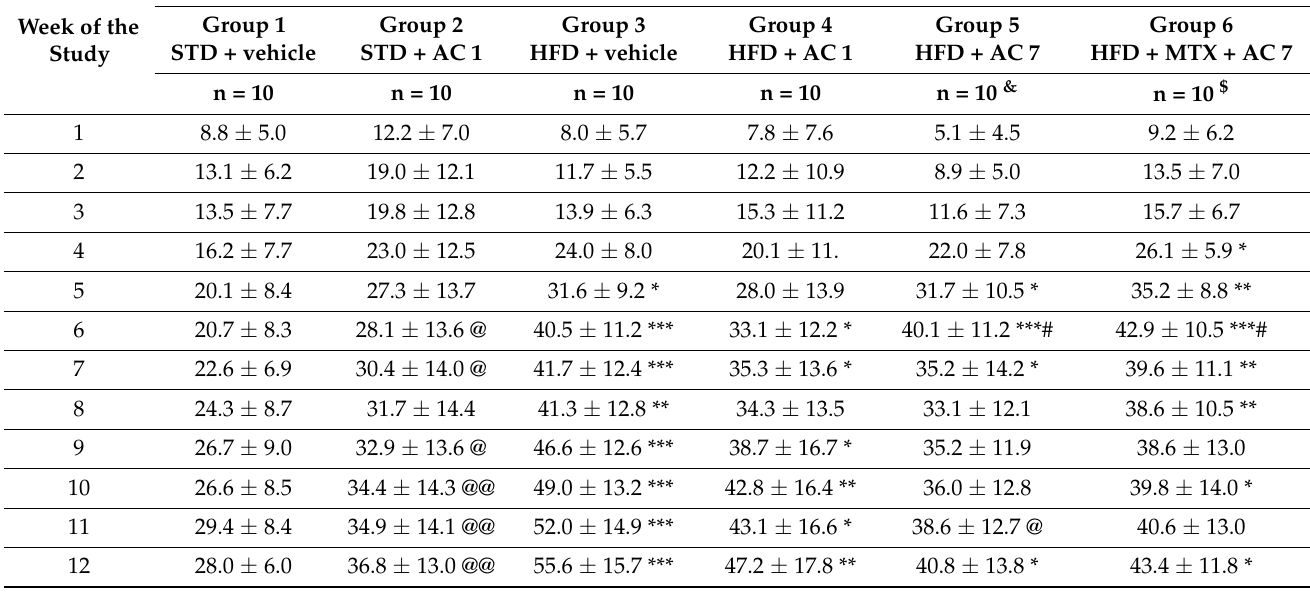
Table 2. Weight gain.